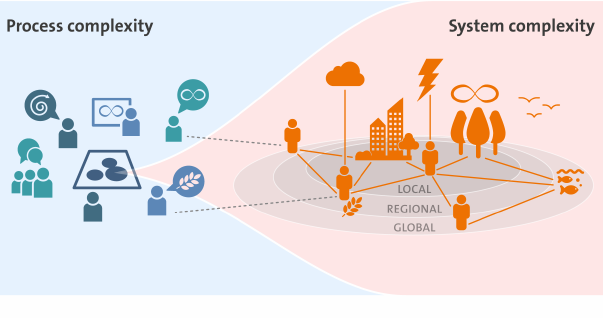
Fig. 2 . Operationalizing complexity. The cases of